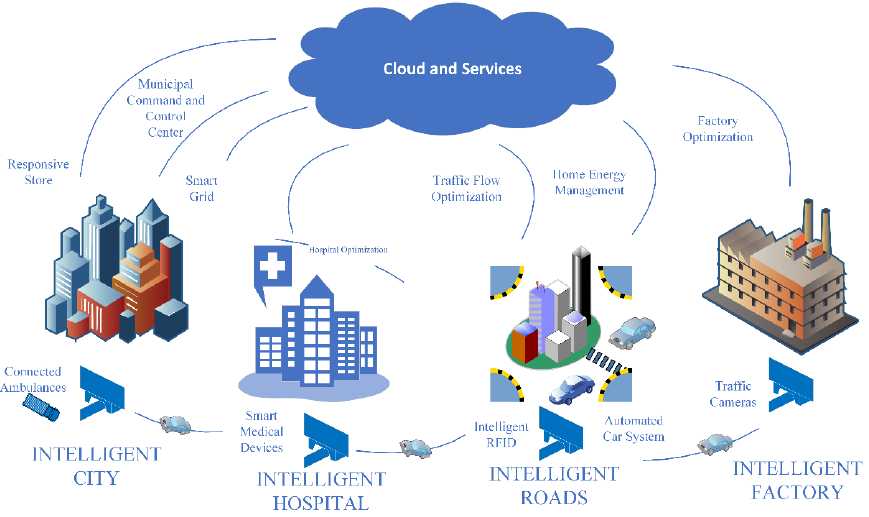
Figure 1. Application Scenarios for IoT.